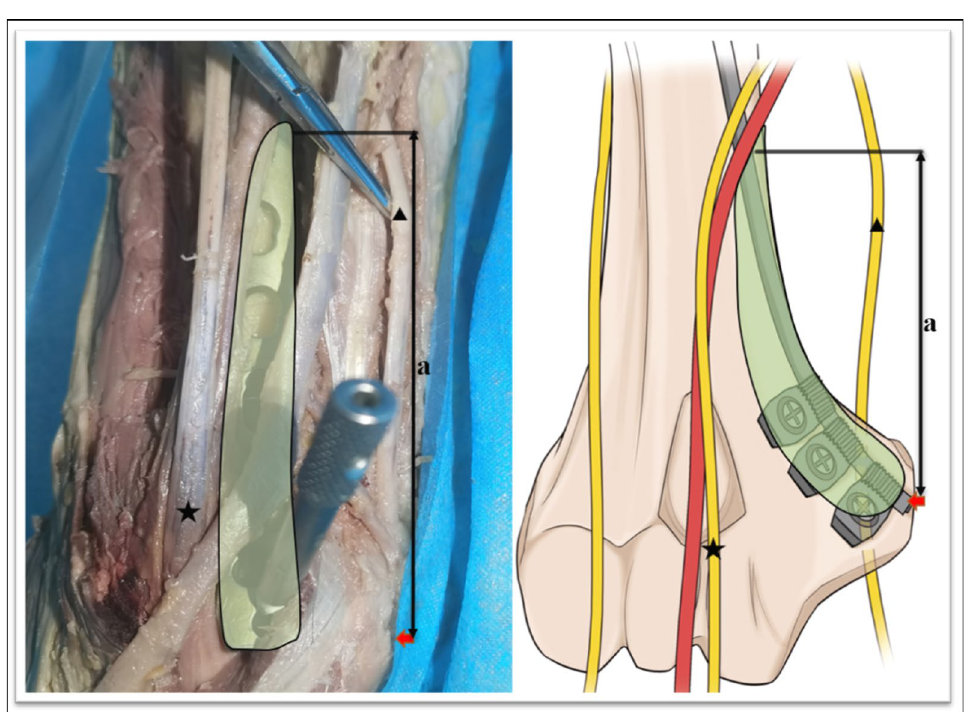
Fig. 4 This figure shows the distance from the vertex of the epicondyle to the intersection of the median nerve and the distal end of the underlying steel plate ( a ). Green areas represent the safe area where the screw is placed at the distal end. The pentagrams indicate the median nerves. The triangles indicate the ulnar nerves. The red arrows indicate the medial